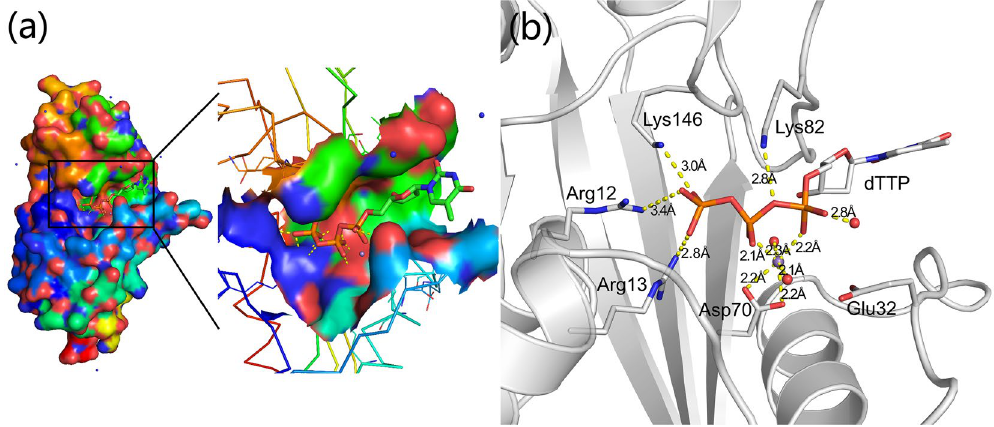
Figure 3. The complex structure model of YhdE_E33A and dTTP. ( a ) dTTP binding surface of YhdE_E33A. The substrate dTTP is shown as sticks, and the protein is in surface representation. The triphosphate group of substrate dTTP is buried inside the active pocket of YhdE. ( b ) The active site pocket of YhdE_E33A. dTTP and residues Arg12, Arg13, Glu32, Asp70, Lys82 and Lys146 are shown as sticks along with protein backbone as cartoon (grey). The hydrogen bonds between YhdE residues with dTTP, as well as interactions with Mn 2 + ion are represented in dash lines (yellow). The triphosphate group of dTTP forms many hydrogen bonds with basic residues of YhdE. The carboxyl group of Asp70 together with α - and β -phosphoryl groups of dTTP and two water molecules coordinate Mn 2 + , which form an octahedral structure.